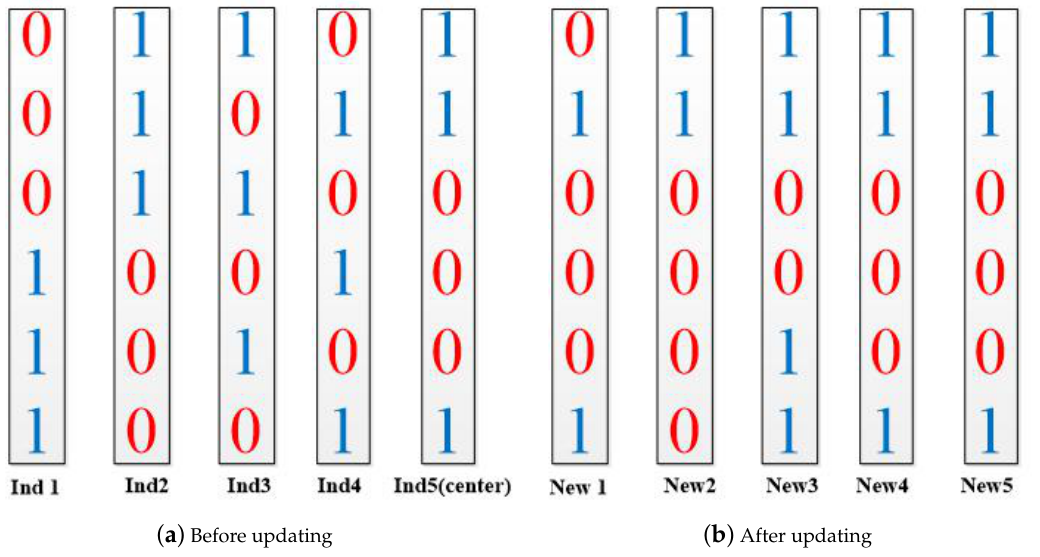
Figure 2. An example of brainstorm optimization (BSO) algorithm’s updating